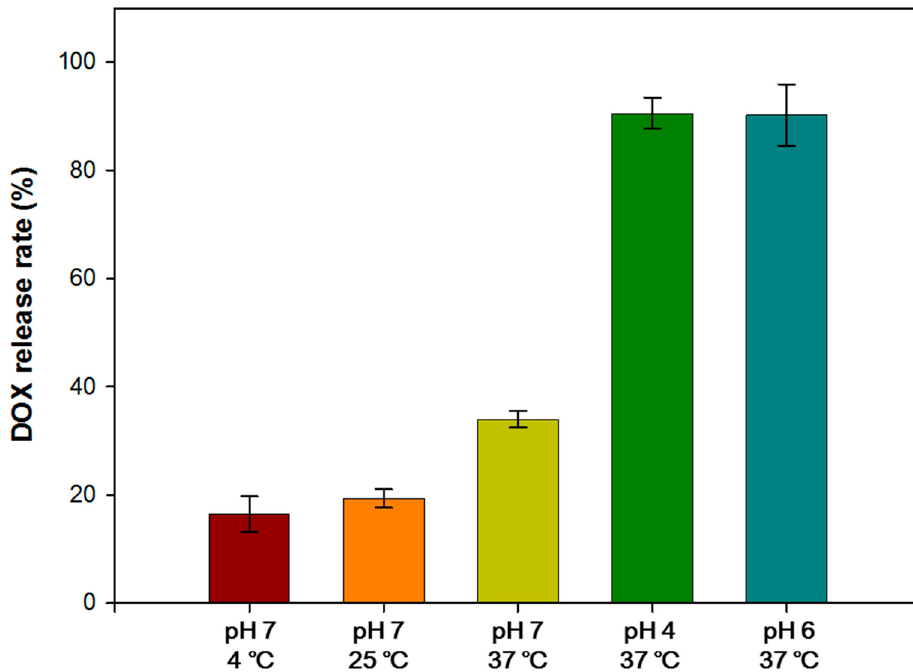
Figure 4. The DOX release rates of DG/FA NPs soaked in PBS of various pH values and